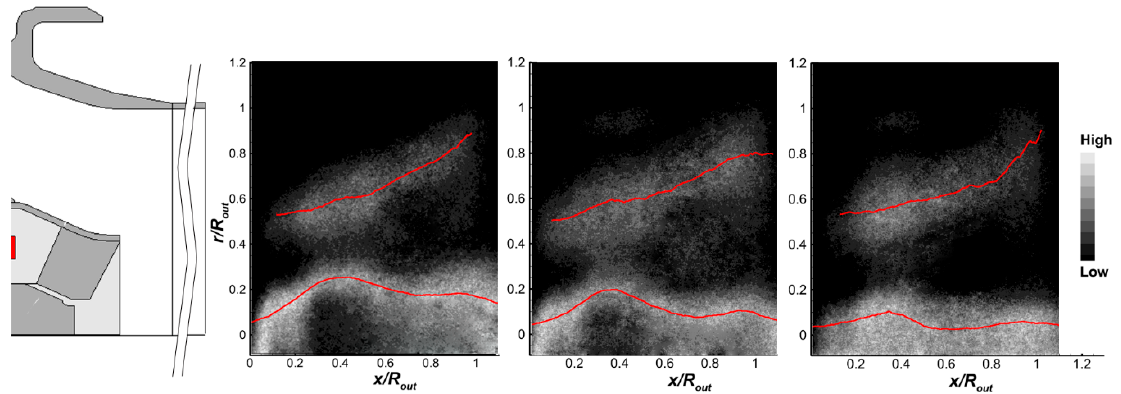
Figure 10. The average location of flame fronts related (from left to right) to the operating conditions from #1 to #3. The red line shows the most probable position of the flame fronts, both placed within the inner recirculation zone (IRZ) and at the inner shear layer.